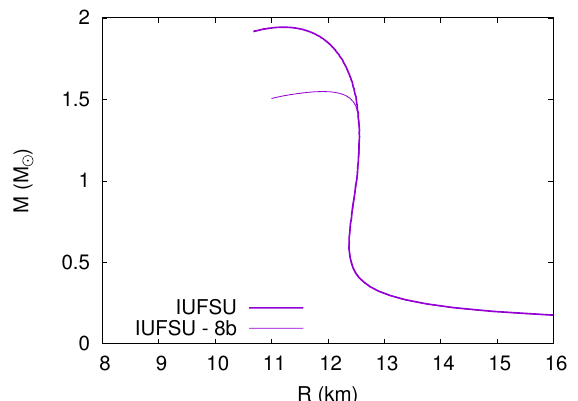
Figure 11. Mass–radius diagram obtained with the IUFSU parametrization for hadronic matter with (8b) and without